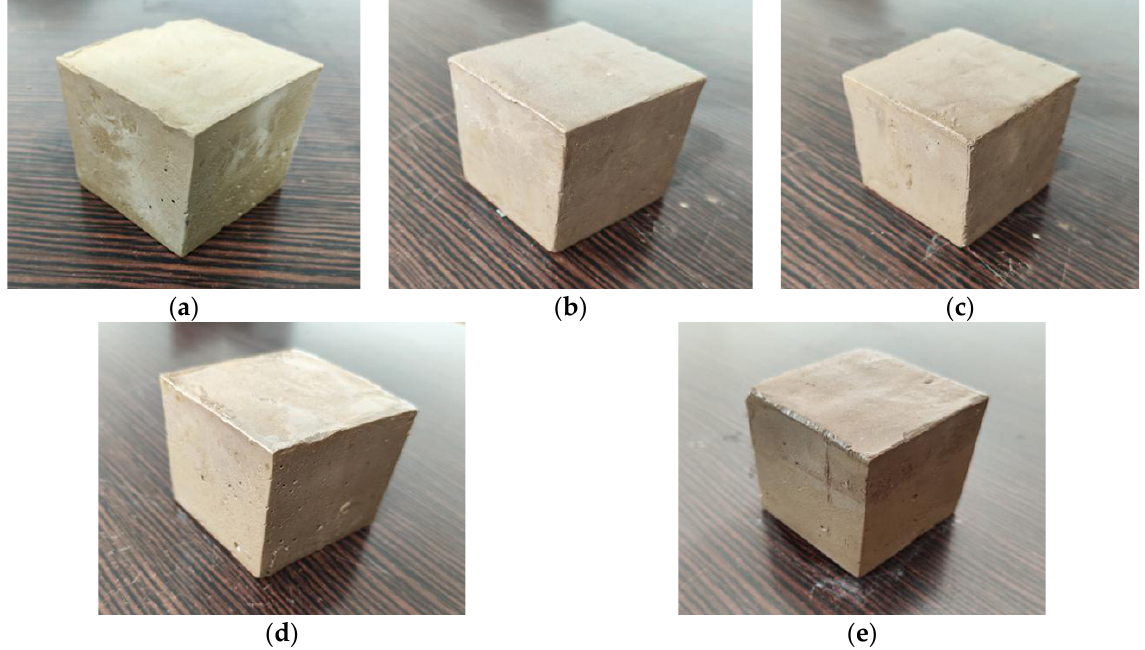
Figure 3. Appearance changes of geopolymer-stabilized soil (G-2 group) at different sulfate erosion ages: ( a ) 3 d; ( b ) 7 d; ( c ) 28 d; ( d ) 60 d; ( e ) 90 d.